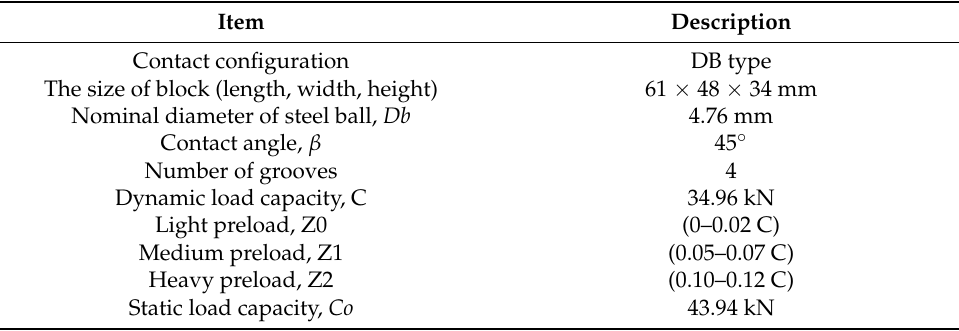
Figure 1. Schematic of linear rolling guide: ( a ) internal constructions and ( b ) arrangements of ball grooves [38]. Table 1. Specifications of linear guide used in this